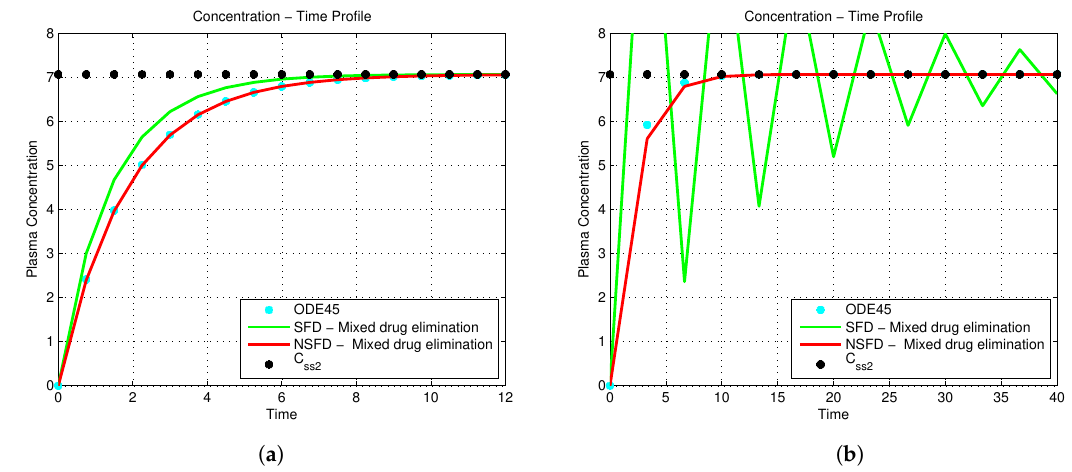
Figure 10. NSFD scheme (53) and SFD scheme (54) is comparison with ODE45. C ss 2 is the steady state Equation (52). The concentration of the drug when administered via I.V. bolus infusion and eliminated by mixed drug processes for ( a ) h = 0.75 and ( b ) h =